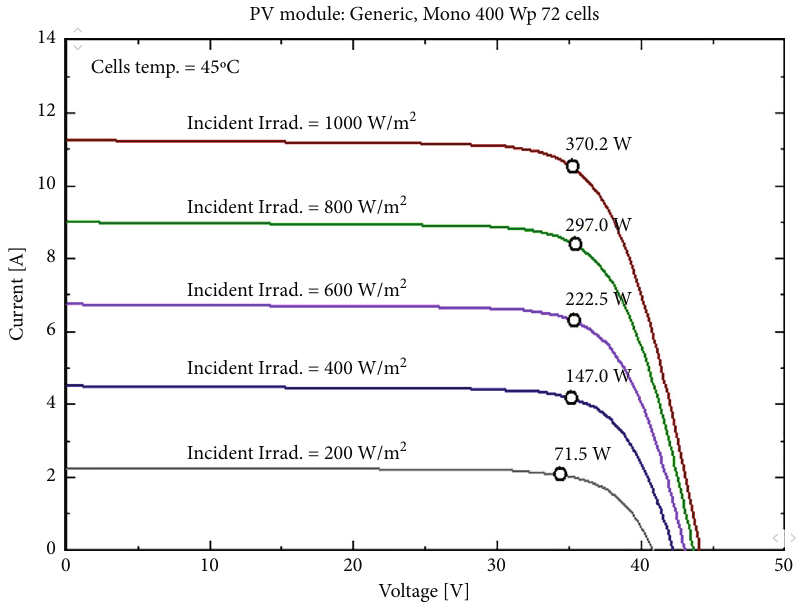
Figure 3: Current versus voltage characteristics of 400 W PV module.